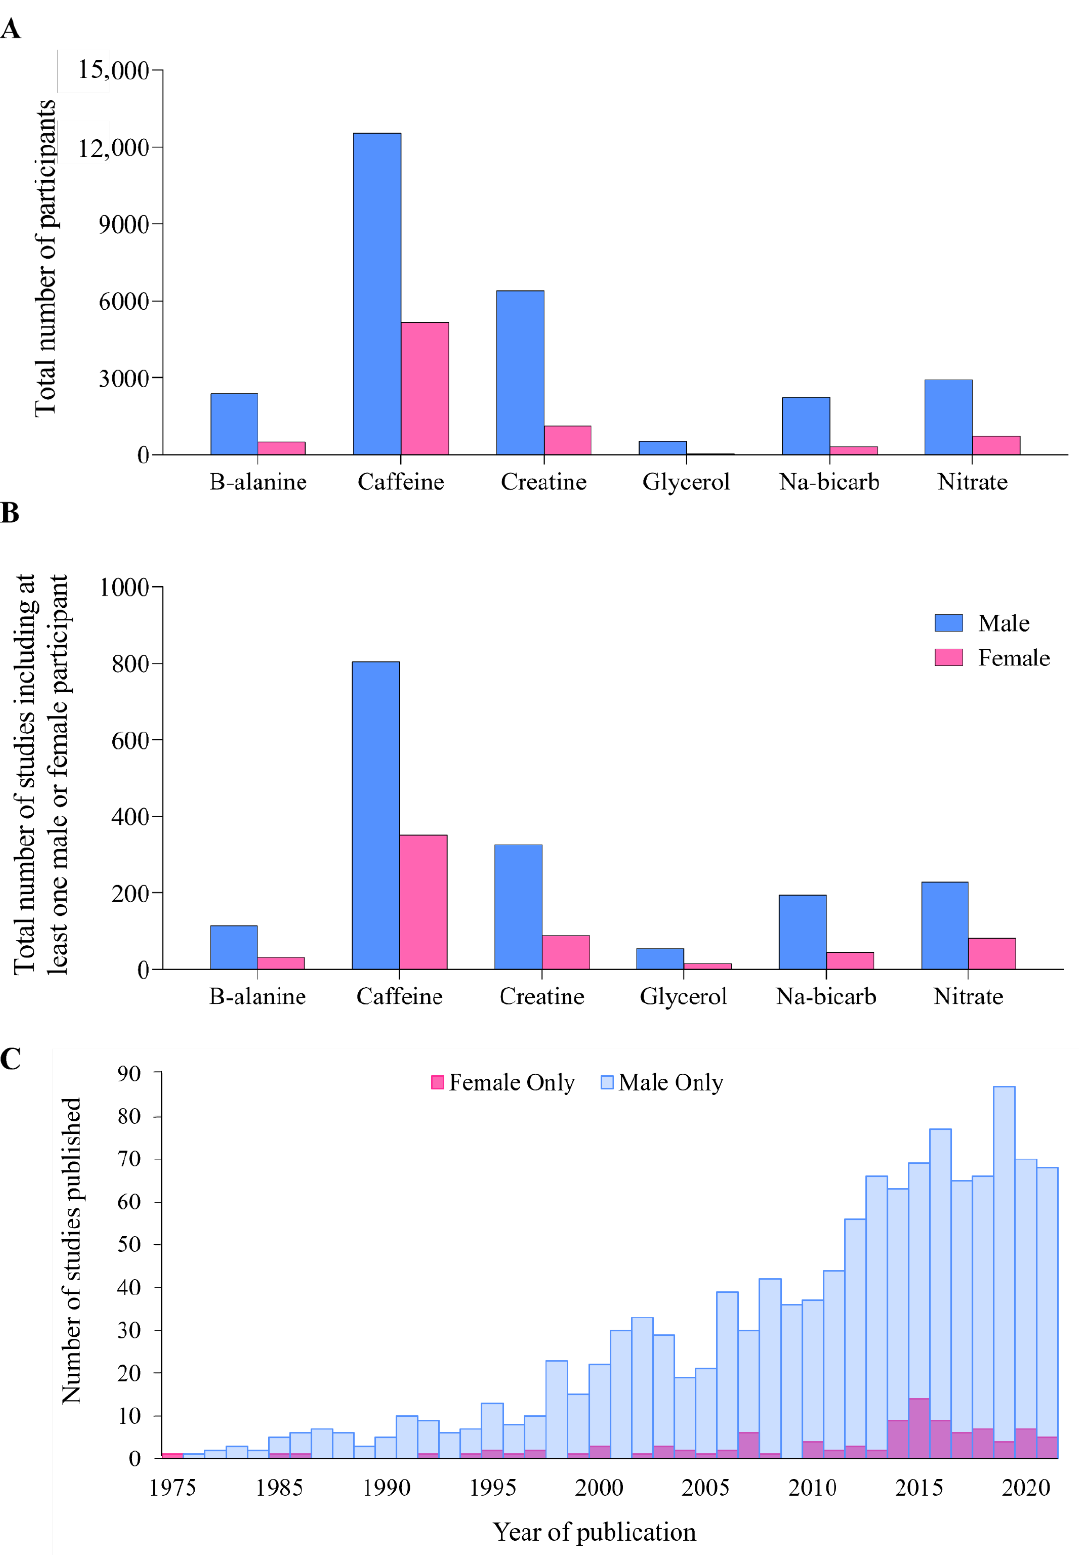
Figure 2. ( A ) The total number of male and female participants included across all studies, separated per supplement, ( B ) the total number of studies including at least one male or female participant, per supplement, and ( C ) histogram displaying the total number of studies published in exclusively male or female participants between 1975 and 2021 across all performance supplements.